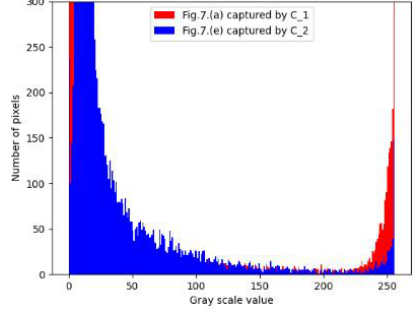
Fig. 8. Histogram of Fig.7.(a) and Fig.7.(e).